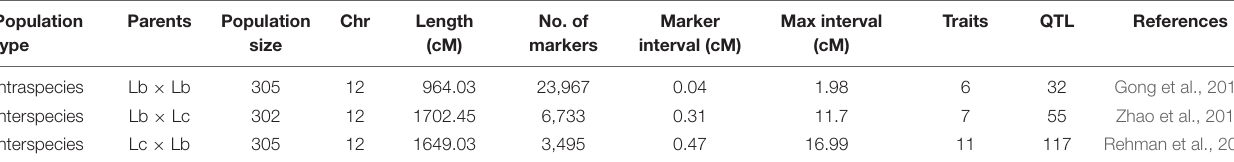
TABLE 2 | Genetic map construction and QTL mapping in Lycium